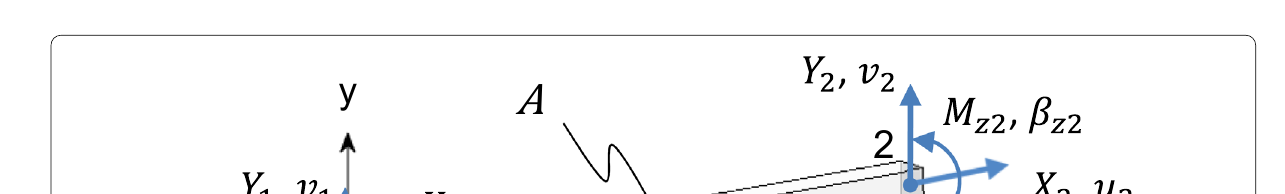
Fig. 6 Dimensions of CLT used for shear analogy method